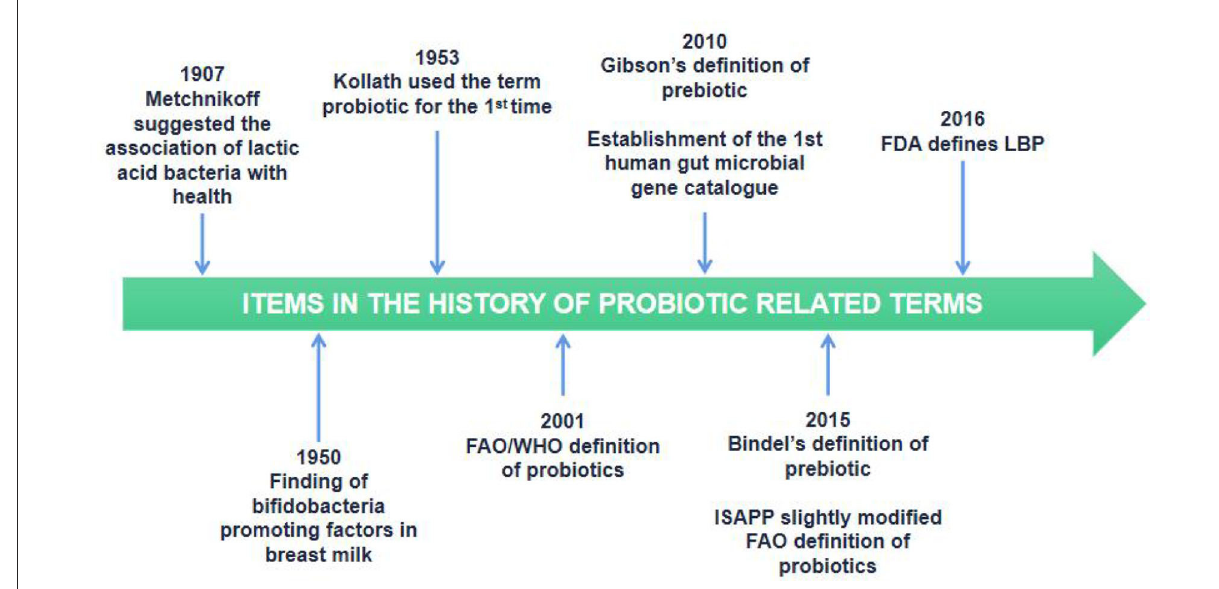
FIGURE4 Timeline of selected items in the history of probiotic related